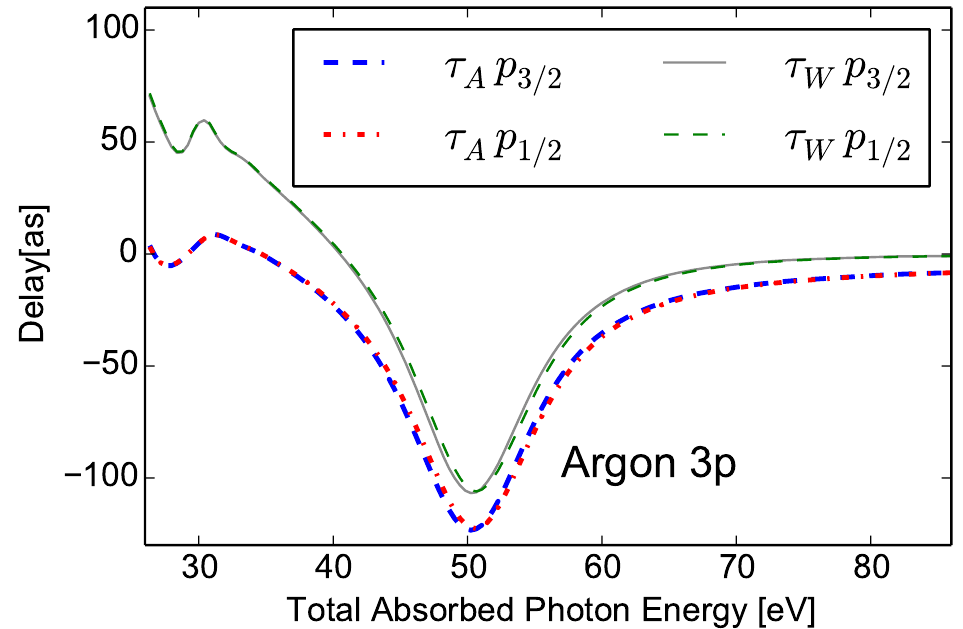
Figure 2. The atomic and Wigner delay calculated in length gauge for ionization from Ar 3 p j , for electrons emitted along the polarization axis. The figure shows the region in the vicinity of the Cooper minimum. The thick dashed blue line shows the atomic delay for electrons ionized from 3 p 3/2 . It is hardly distinguishable from the dashed–dotted red line that shows the atomic delay for electrons ionized from 3 p 1/2 . The thin dashed green and solid grey lines show the Wigner delay for electrons ionized from 3 p 1/2 and 3 p 3/2 respectively. Dirac–Fock orbital energies have been replaced with experimental ionization energies: For 3 p 3/2 the binding energy is 15.76 eV, and for 3 p 1/2 it is 15.94